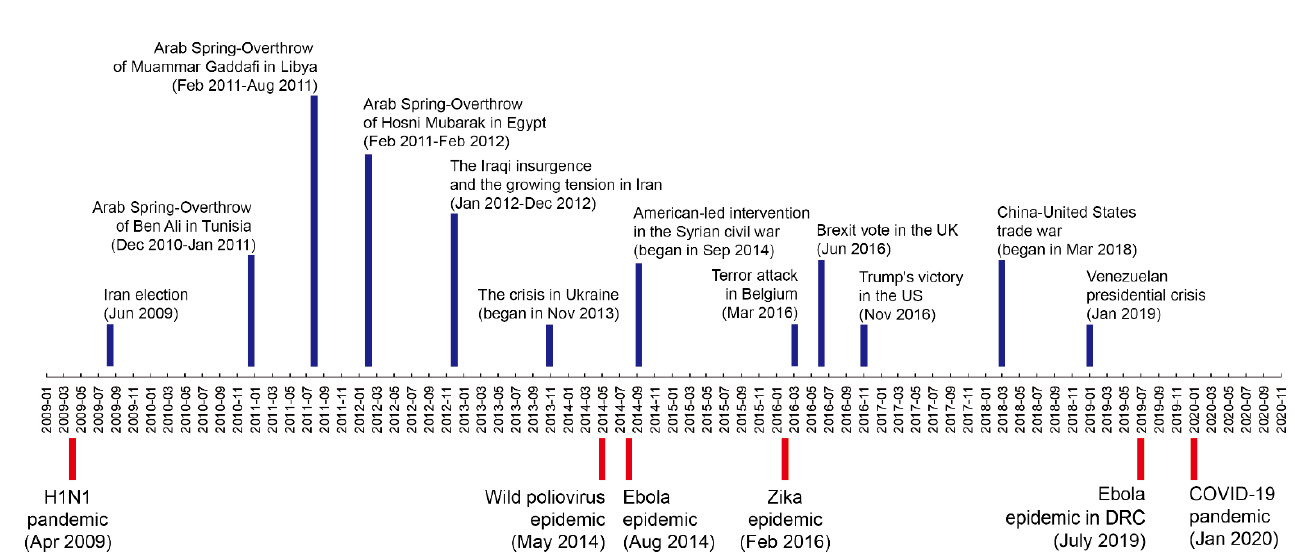
Figure 5. Important events in the Middle East and other major economies since